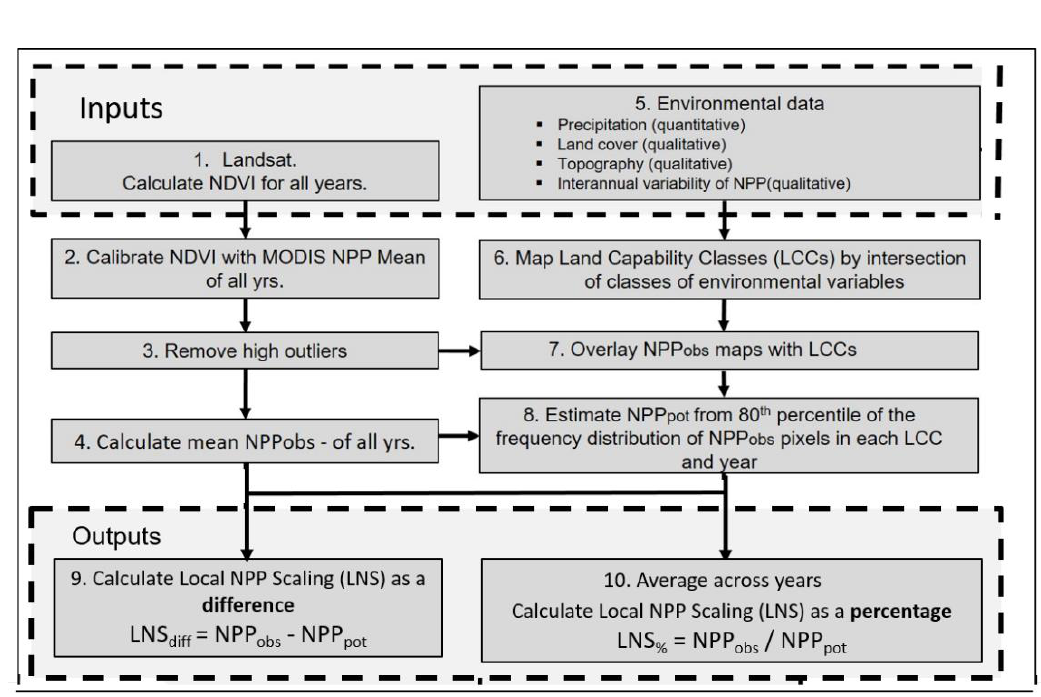
Figure 2. Schematic diagram of data processing steps. Boxes 1 and 5 are the data inputs and 9–10 the outputs used in the analyses.